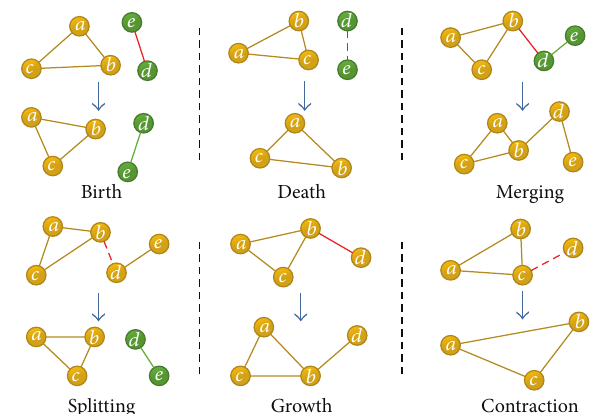
Figure 5: Six events provide variation of community cores. The red solid/dash line denotes the link add/remove separately, and different colors mean different community